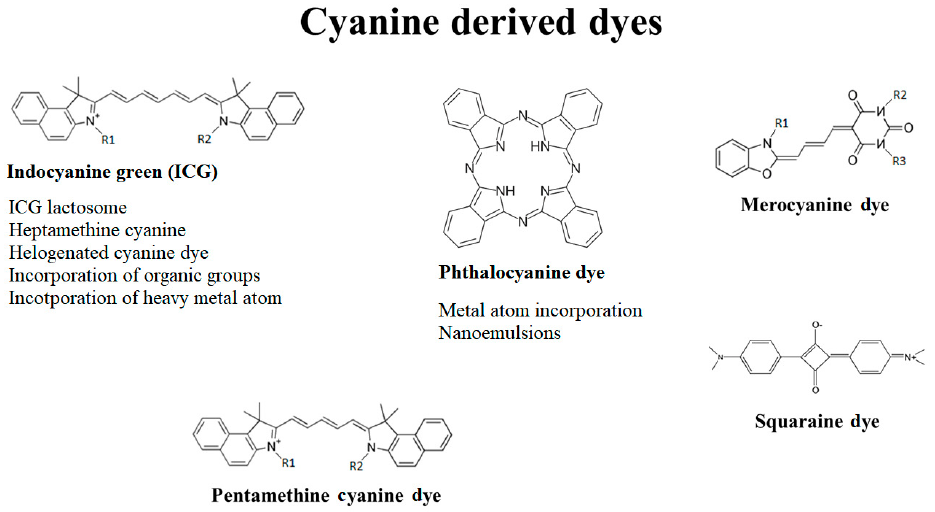
Figure 3. Cyanine-derived dye division and backbone structures. R1, R2 and R3 represent the organic substituent groups.